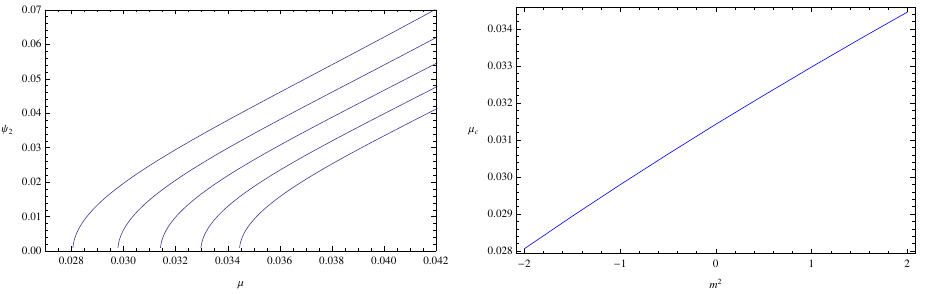
Figure 3 . (Color online) In the left panel, we show ψ 2 as a functions of µ with q = 100, C 4 = 0 and various mass m 2 from left to right as: m 2 = − 2, m 2 = − 1, m 2 = 0, m 2 = 1 and m 2 = 2. In the right panel, we plot the critical chemical potential µ c as a function of the scalar mass m 2 with q = 100 and C 4 = 0.